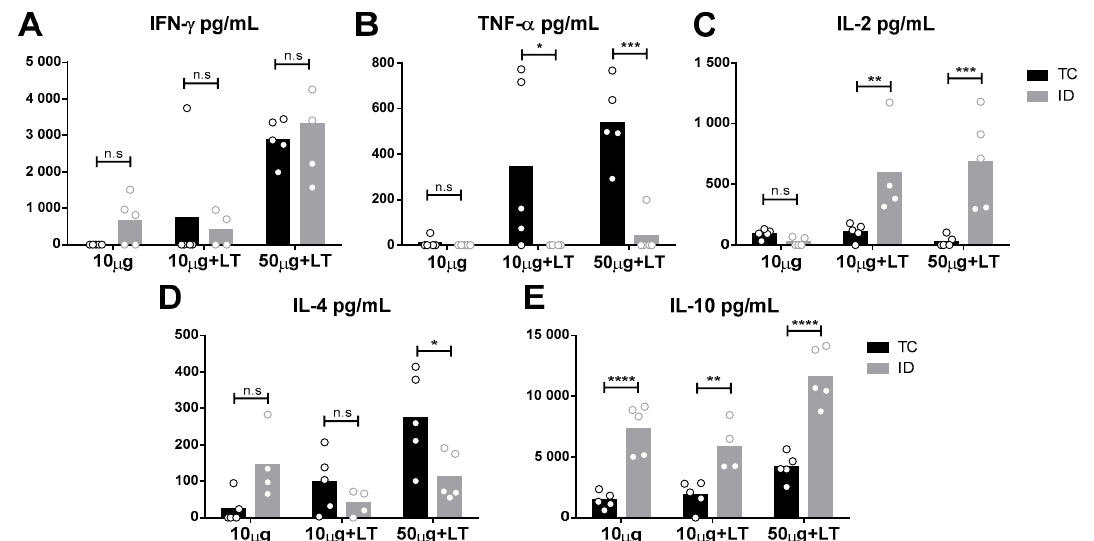
Figure 3. Cytokine secretion profile detected in mice submitted to TC and ID immunizations with DENV2 particles. Spleens of immunized mice ( n = 5 / ID 10 µ g + LT n = 4) were harvested two weeks